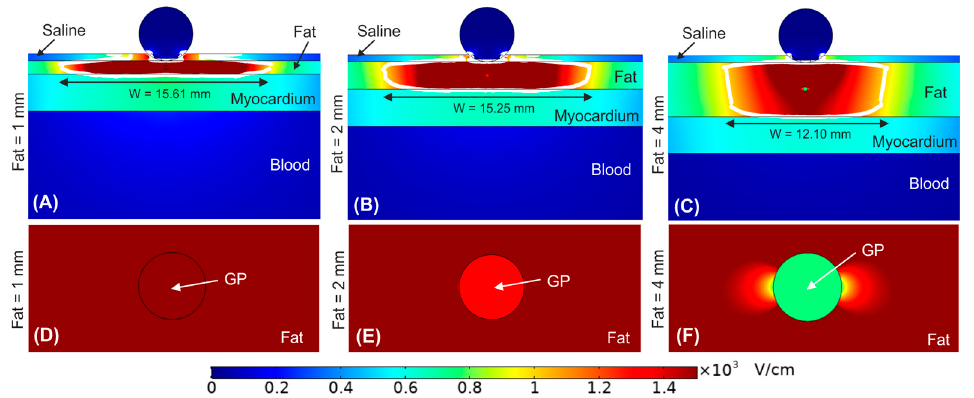
Figure 5. Electric field distribution around the target site (epicardium) to assess the effect of having a ganglionated plexi (GP) in the centre of the epicardial fat layer just below the ablation device. Different fat layer thicknesses were considered for comparison: ( A ) 1 mm, ( B ) 2 mm, and ( C ) 4 mm fat layers. Below is shown a magnified view of the GPs within the different fat layer thicknesses: ( D ) 1 mm, ( E ) 2 mm, and ( F ) 4 mm. The ablation device is totally embedded in the saline layer. The white contour corresponds to the 1000 V/cm electric field